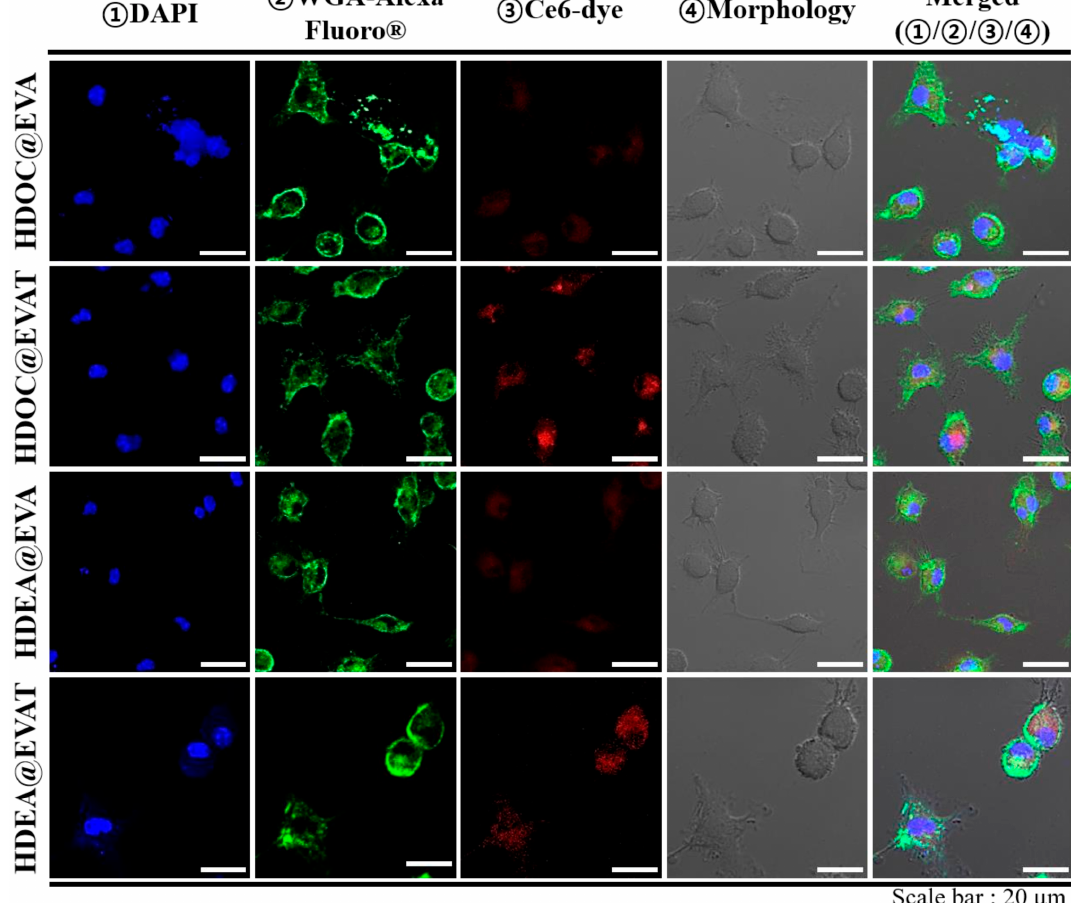
Figure 4. ( a ) Flow cytometry analyses or ( b ) mean fluorescence intensity (MFI) of DCs treated with fluorescent Ce6-labeled EVs after incubation for 4 h at 37 ◦ C ( n = 3).